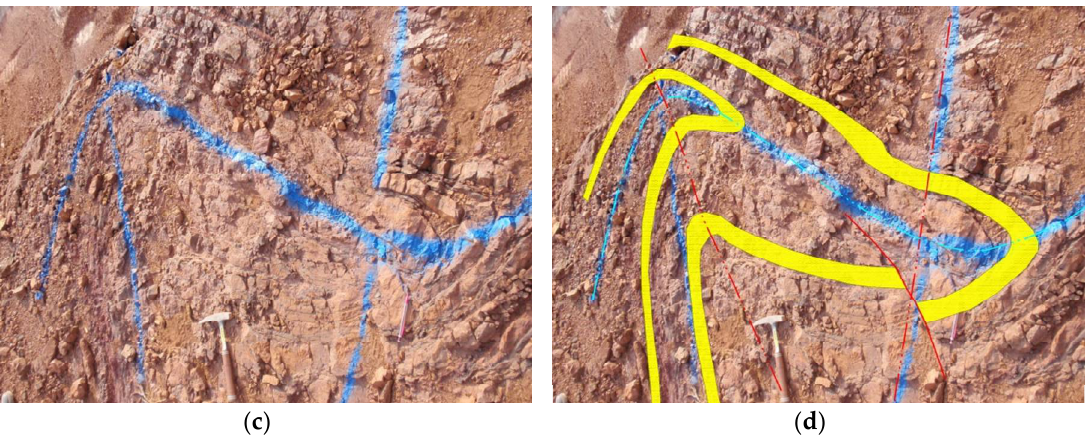
Figure 8. Examples of outcrop-scale D 2 –D 3 fold interference patterns in the central Kukuluma terrain, shown as annotated pairs. Marker layers have been highlighted in yellow; the D 2 fold axial trace is shown in light blue; the D 3 fold axial trace is shown in red. ( a , b ) Vertical view of fold pair in erosion gully along the eastern face of Matandani pit; ( c , d ) Horizontal view of fold pair on the upper benches in the southwest corner of Matandani pit.